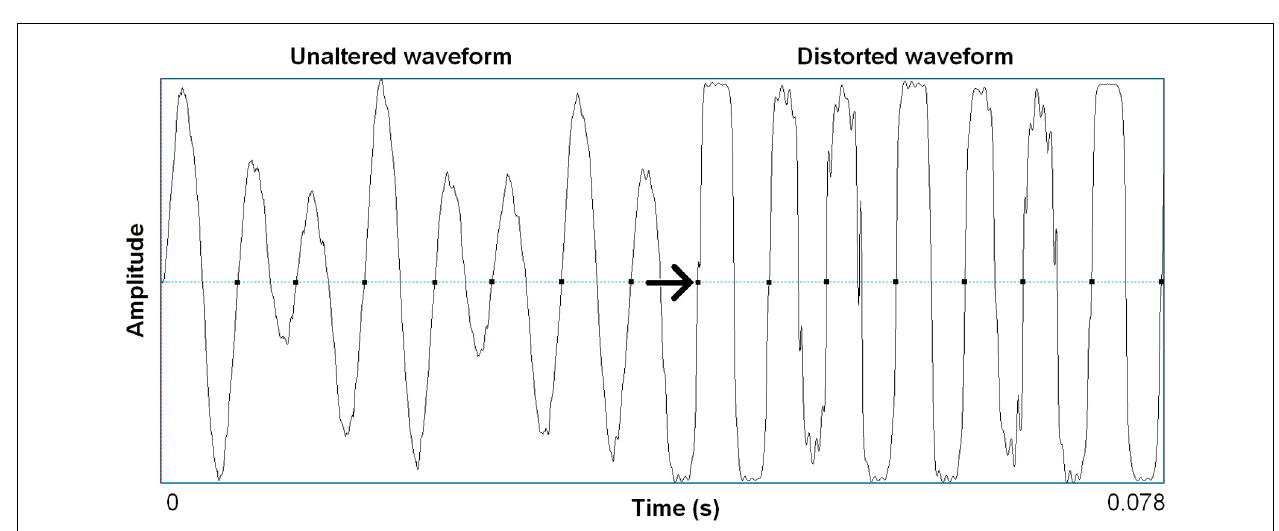
FIGURE 3 |Waveform segments taken from recording shown in Figure 2 of seven cycles (78 ms) of unaltered acoustic guitar, and the same seven cycles after wave shaping function (Camel CrusherVST Plug-in). Arrow notes onset of wave shaping.